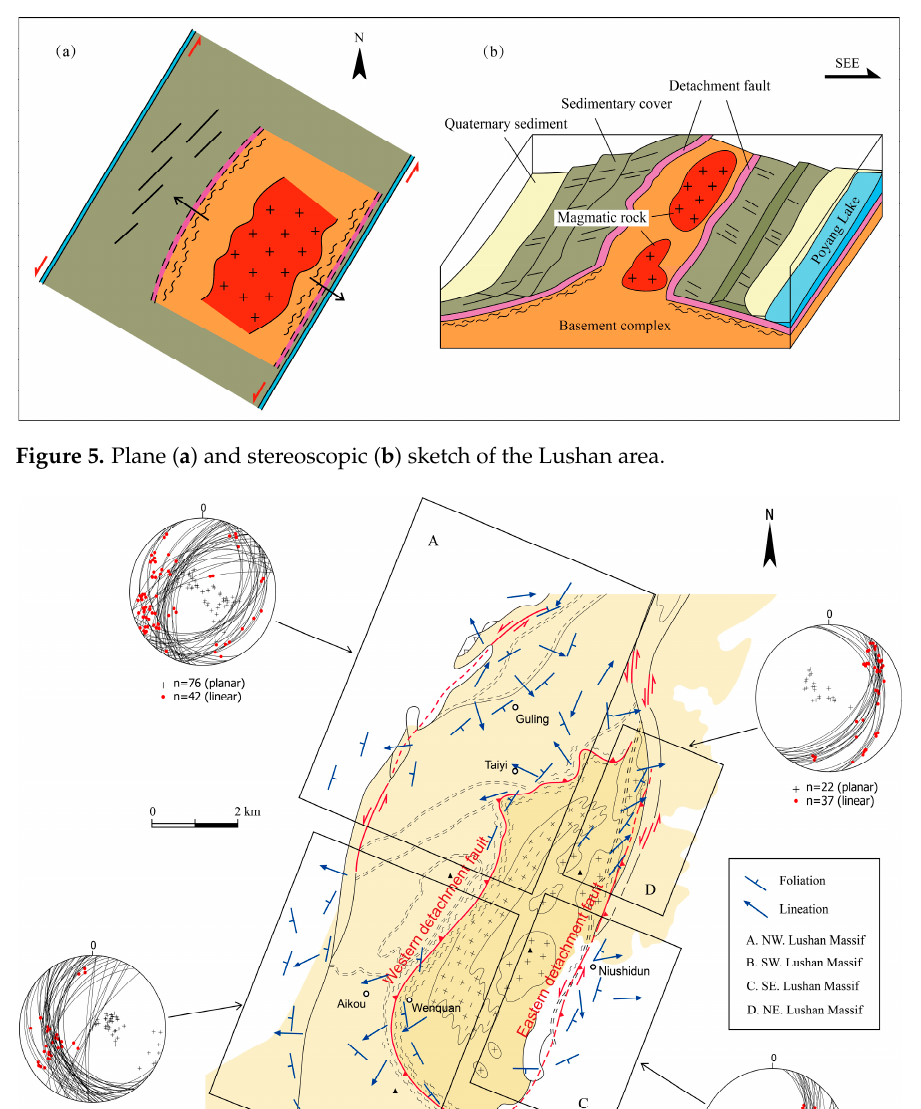
Figure 4. Field and microscopic photographs related to ductile strike-slip structures. “Ss” represents mylonitic foliation, and red arrows represent motion directions in the following figures. ( a ) Fold boudin that indicates the deformation direction in the XZSZ. ( b ) Sigma-shape feldspar porphy- roblasts and oblique quartz grain shape fabrics indicating shear sense. ( c ) Asymmetric fold that shows the shear direction in the LHSZ. ( d ) S-C fabric indicating shear sense.